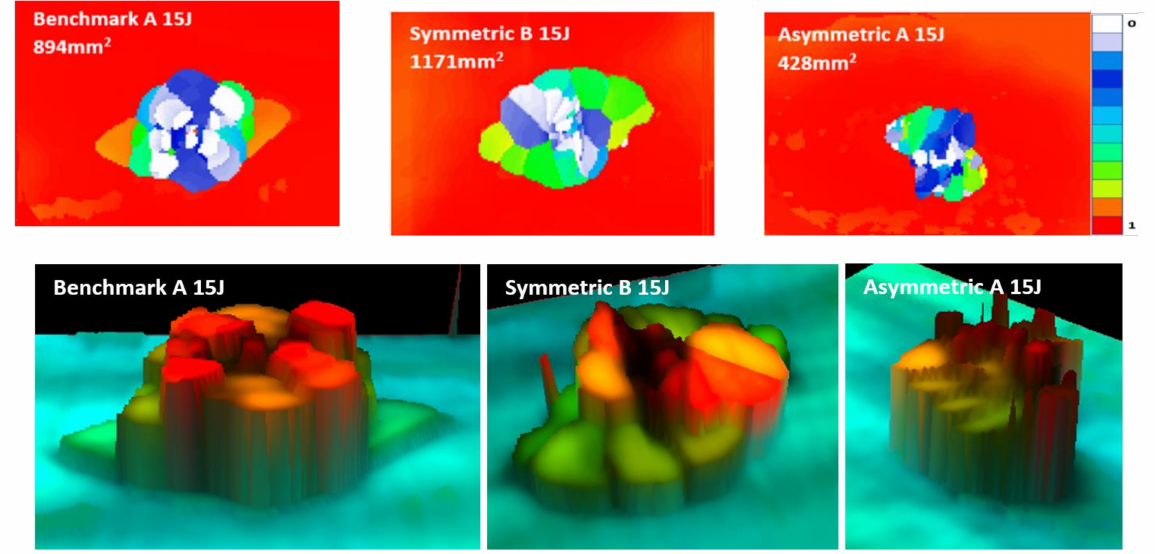
Figure 13. Time-of-flight C-scans and 3D images of the 15 J impact samples for the benchmark, symmetric (FGPS) and asymmetric (FGPA)